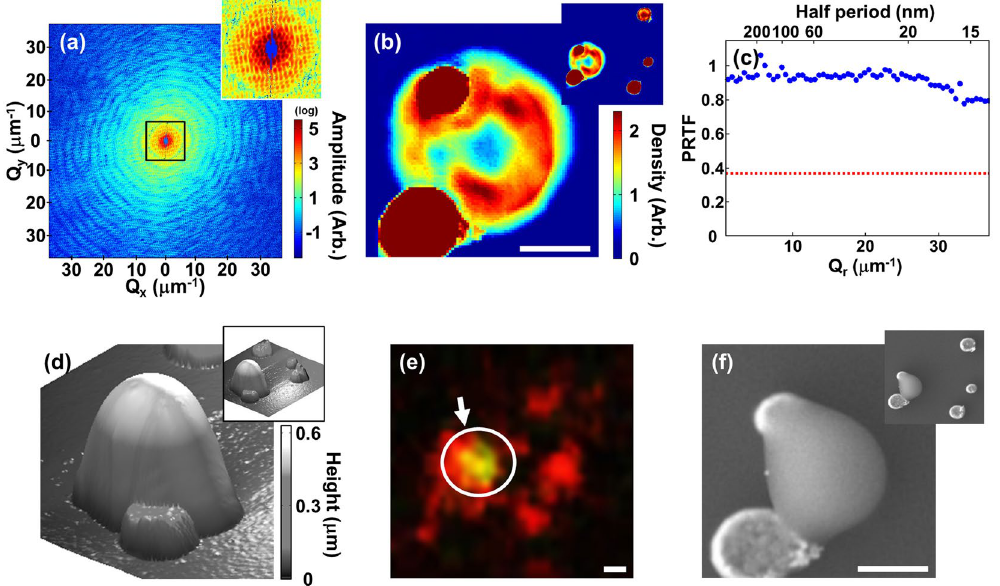
Figure 4. ( a ) Diffraction amplitude from a specimen with a mitochondrion together with Au reference objects. The central part is enlarged in an inset to display details of the speckle pattern. ( b ) CXDI projection image of the mitochondrion reconstructed from ( a ). The red circular objects are the Au reference objects. An image with an enlarged field of view is included in the upper right corner. ( c ) PRTF evaluated from the iterative reconstruction which indicates that the image resolution is around 14 nm. Red dotted line indicates 1/e, the resolution criterion. ( d–f ) AFM ( d ), fluorescence ( e ), and SEM ( f ) image of the same specimen. The green fluorescence emission indicated in ( e ) shows that the measured object is indeed a mitochondrion. The scale bars are 400